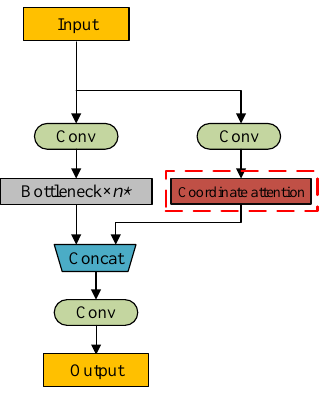
Figure 5. The architecture of CA-C3 module.